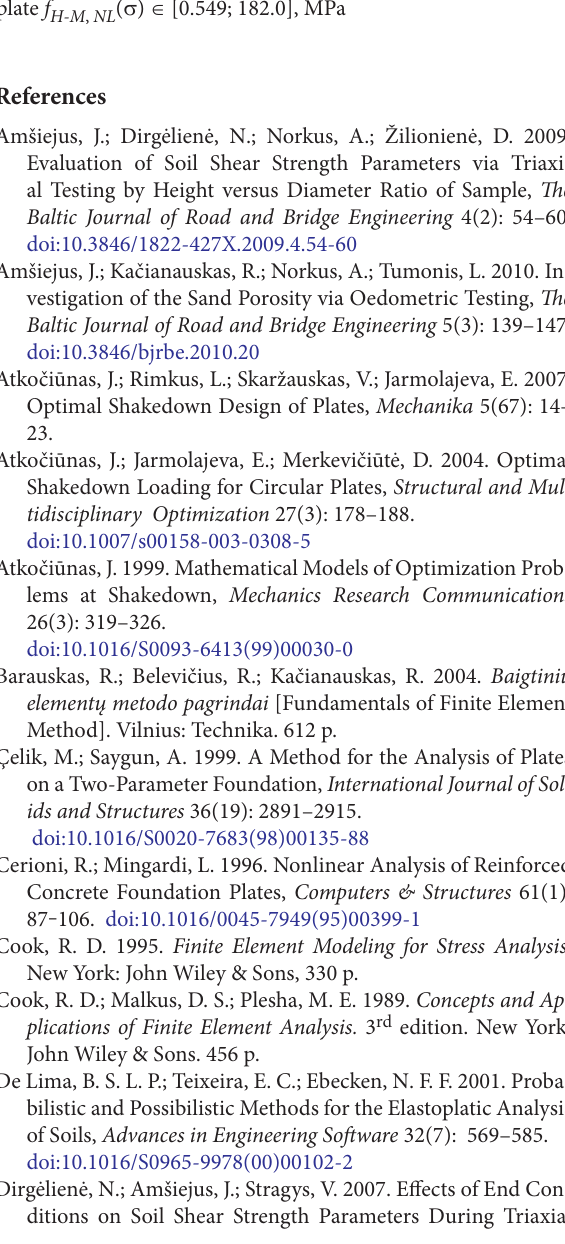
Fig. 13a. Stress intensity contours according to von Mises in the plate f H-M , NL ( σ ) ∈ [0.549; 182.0], MPa